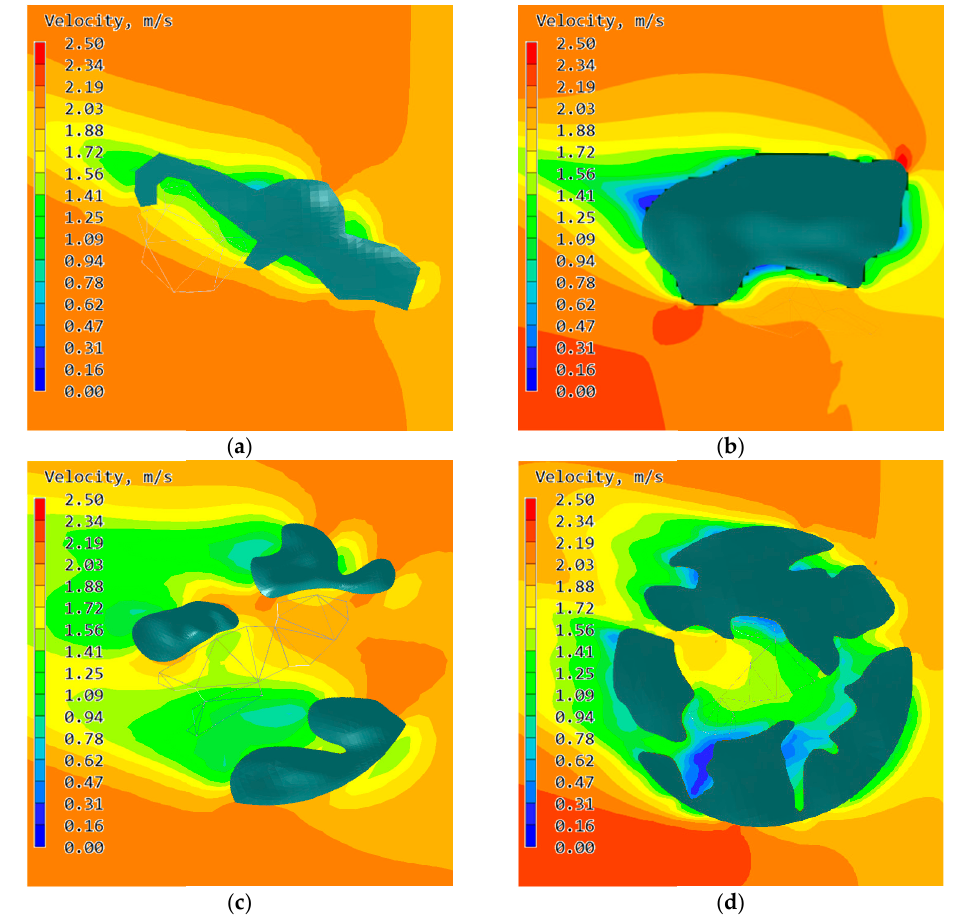
Figure 8. ( a ) Summer wind speed simulation in Xiasong village; ( b ) Summer wind speed simulation in Rongfang village; ( c ) Summer wind speed simulation in Zhuqiao village; ( d ) Summer wind speed simulation in Xuyuan village.